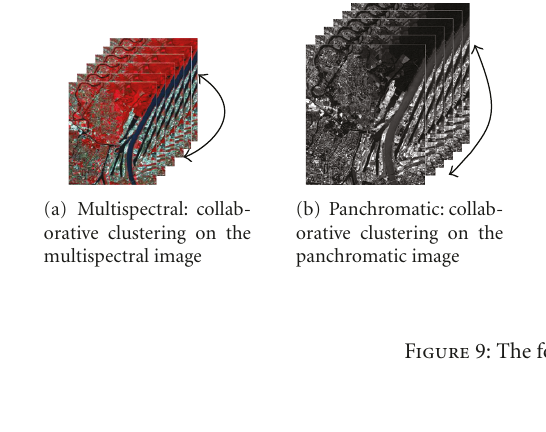
Table 1: Results with ground truth.